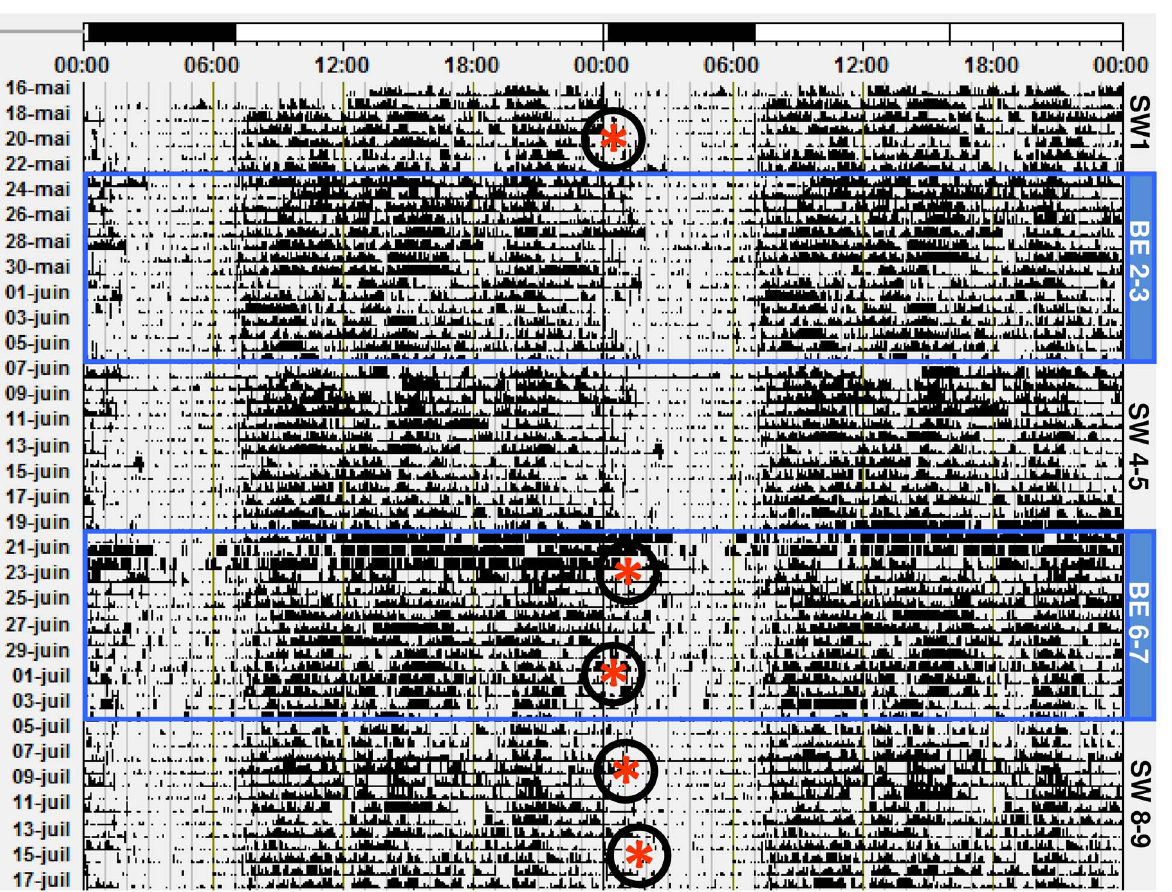
Figure 2. Representative raster plot of continuous actigraphy over 9 weeks, and circadian phase. Subject (S7) had a relatively regular sleep wake cycle across the studyCircadian phase, assessed by DLMO ( * ), shows a phase delay under SW light condition (SW 8–9), but not under BE light condition (BE 6–7), compared to W1.